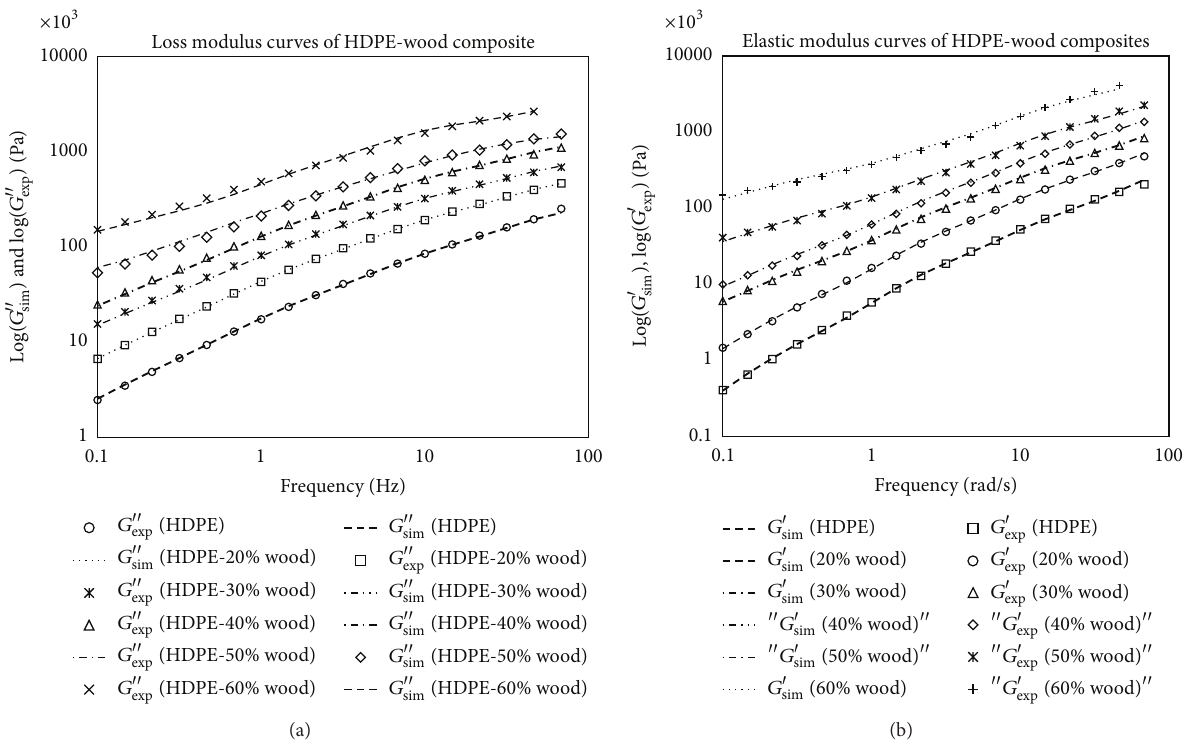
Figure 2: Dynamic modulus (loss modulus (a) and elastic modulus (b)) of WPC composites with different concentration of wood fillers at 𝑇 = 170 ∘